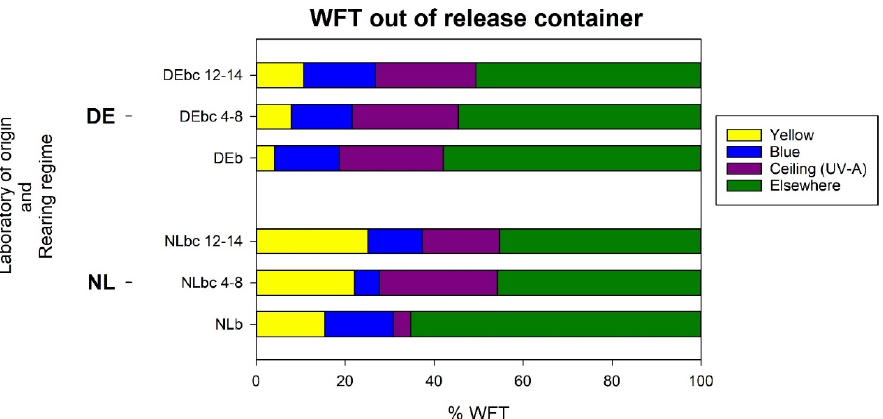
Figure 7. Experiment iii, analysis b : Stacked bar chart showing the percentages of WFT that left the release container as per the laboratory of origin and rearing regime for each of the four categories in which the WFT was grouped inside the wind tunnel. Peak wavelength of LEDs: Blue (477 nm), Yellow (588 nm). DEb: colony of German WFT reared on bean pods for ~20 weeks; DEbc 4-8: DEb colony transferred and reared on yellow-flowered chrysanthemum plants for 4 to 8 weeks; DEbc 12-14: continuation of colony DEbc 4-8 until reaching 12 to 14 weeks reared on yellow-flowered chrysanthemum plants. NLb: colony of Dutch WFT reared on bean pods for ~20 weeks; NLbc 4-8: NLb colony transferred and reared on yellow-flowered chrysanthemum plants for 4 to 8 weeks; NLbc 12-14: continuation of colony NLbc4-8 until reaching 12 to 14 weeks reared on yellow-flowered chrysanthemum plants. All information from this figure including mean percentages and 95% confidence intervals is provided in Supplementary Table S9.